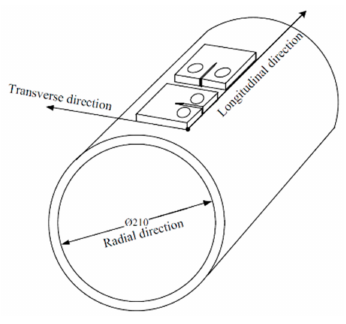
Figure 3. CT specimen